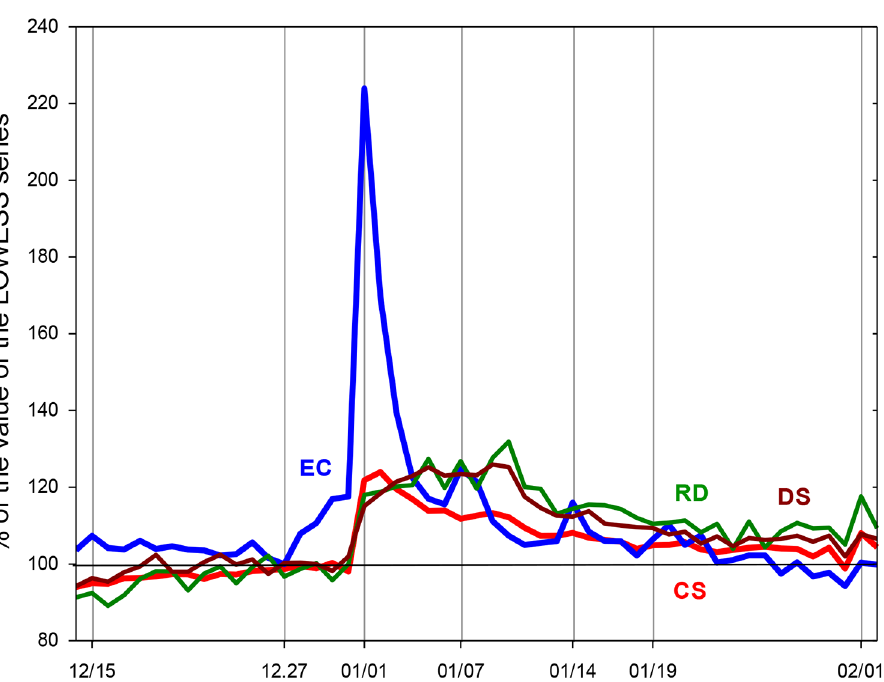
Fig. 4. The daily number of excess deaths in Russia from December 15 to February 1, the sum of indi- cators for 2011–2019, % of the LOWESS moving average which is taken as 100%. Note: EC — external causes, CS — diseases of the circulatory system, RD — diseases of the respiratory system, DS — diseas- es of the digestive system. Source: authors’ calculations based on modelling and Rosstat